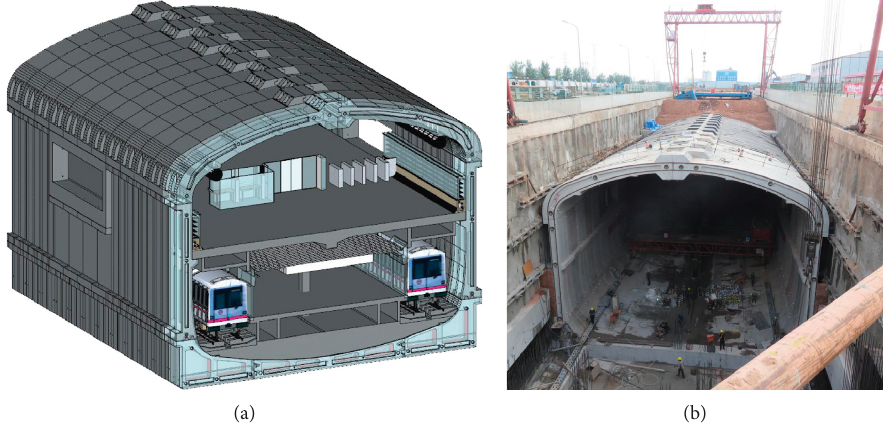
Figure 1: Metro station constructed of prefabricated components: (a) rendering and (b)